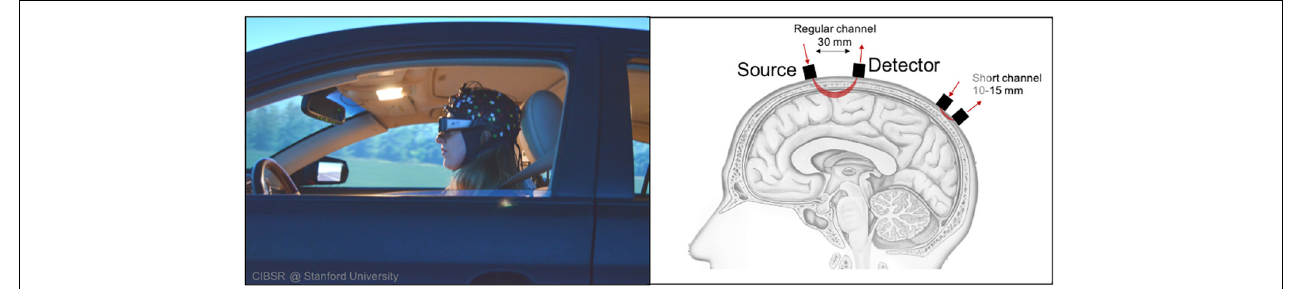
FIGURE 2 | fNIRS’ methodological flexibility allows study of cortical activation during driving